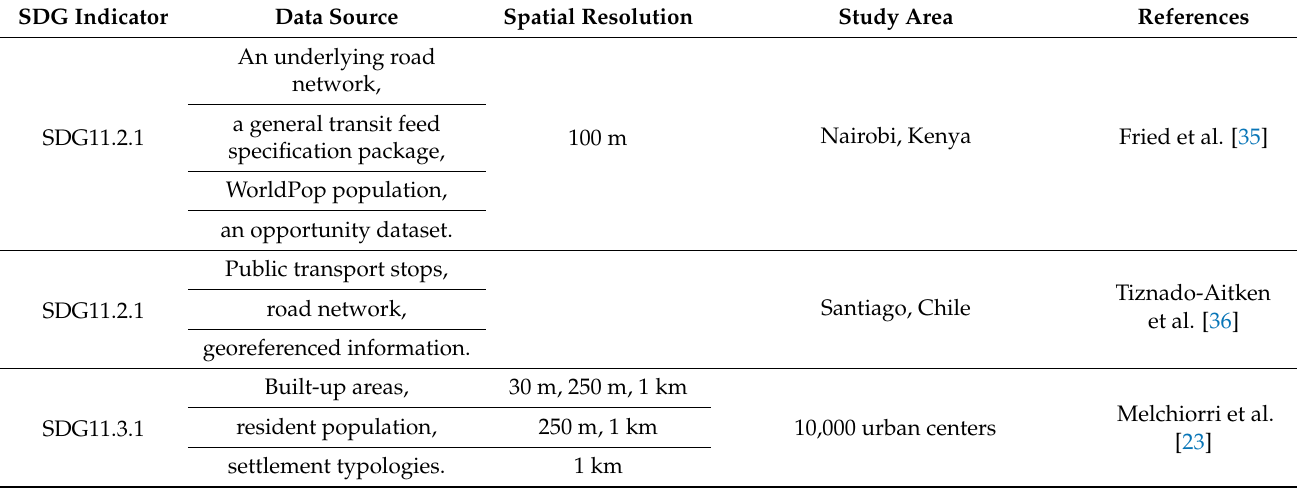
Table 1. Literature review of three SDG11 indicators using geospatial